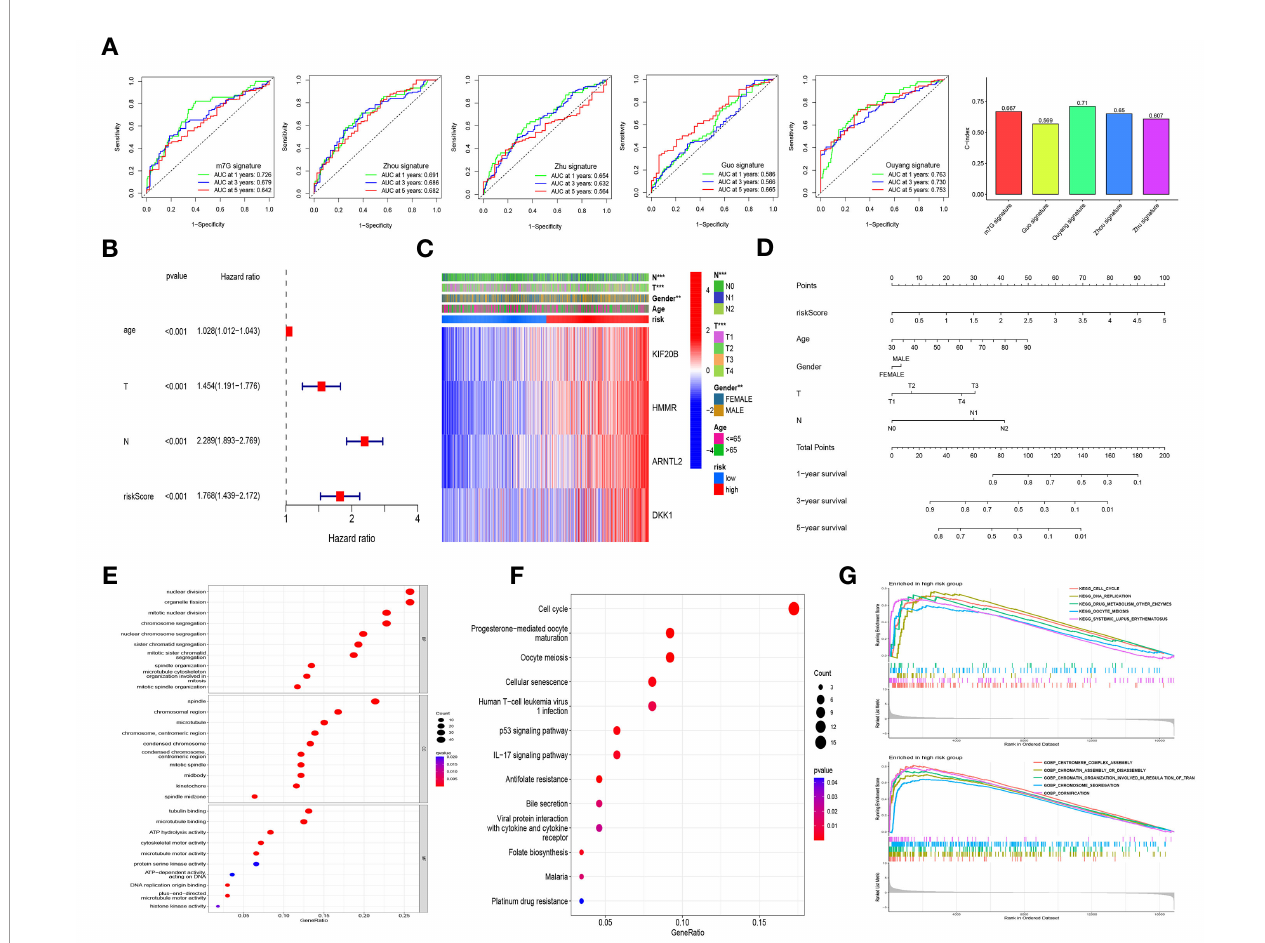
FIGURE 6 | Model comparison, independent prognostic factor analysis, clinical correlation analysis, nomogram construction, and functional and pathway enrichment analyses in the different risk cohorts. (A) The comparison of our prognostic model and previously reported models using ROC curves and concordance index (C-index) values. (B) The multivariate Cox regression analysis of the risk score and other clinical features in the training cohort. (C) Heatmap for the distribution of clinicopathologic characteristics between the high- and low-risk groups in the combined lung adenocarcinoma (LUAD) dataset of the TCGA and GSE68465 cohorts. (D) A nomogram using risk scores combined with clinical characteristics. GO enrichment analysis (E) and KEGG pathway analysis (F) based on the differentially expressed genes between the high- and low-risk groups in the combined LUAD dataset. (G) Gene set enrichment analysis (GSEA) based on KEGG and GO in the high-risk group in the combined LUAD dataset. ** p <0.01, *** p <